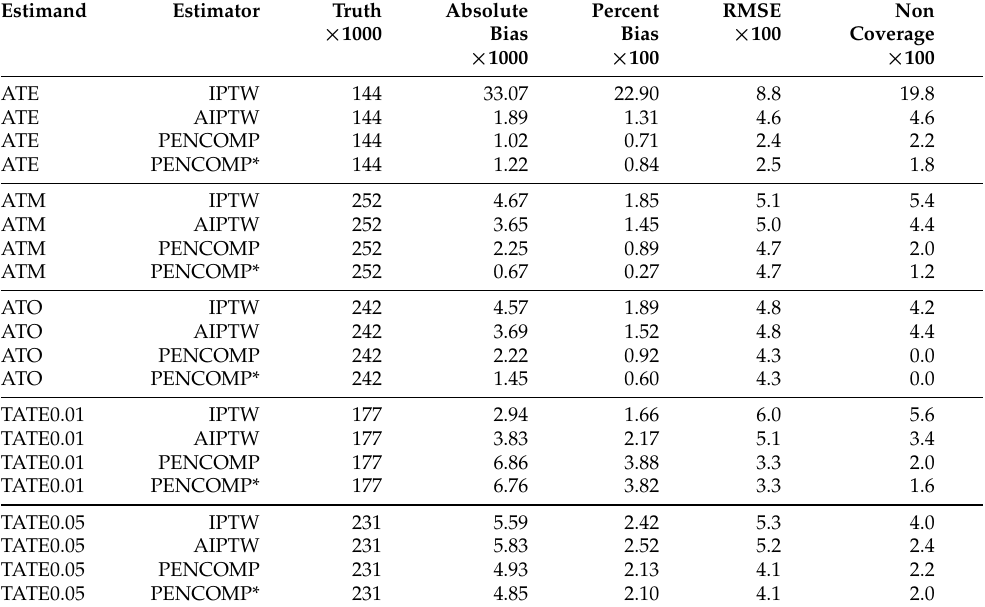
Table 5. Empirical bias (in absolute and percentage), RMSE, and 95% CI (non) coverage, across the methods for a binary outcome in the scenario where the outcome models were misspecified. Results were based on 500 simulations with sample size of 500; 500 bootstraps were used to estimate standard errors for the weighted estimators and 200 complete datasets for PENCOMP. PENCOMP* denotes the outcome misspecification with a null outcome model by fitting a penalized spline on the propensity score only. ATE = Average treatment effect; ATM = average treatment effect on an evenly matchable set; ATO = average treatment effect on the overlap population; TATE α = truncated average treatment effect with a truncation at a pre-defined α level.